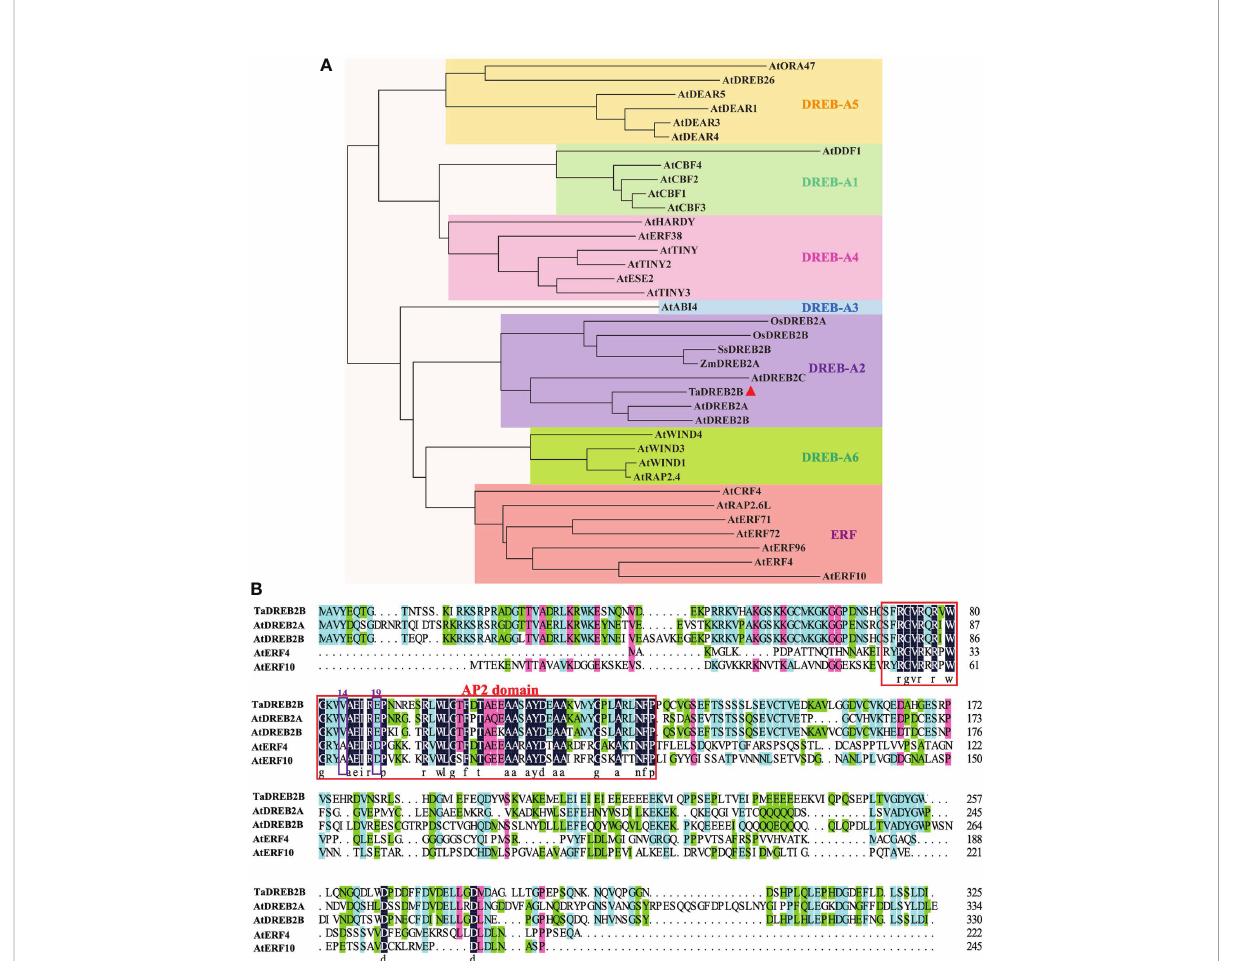
FIGURE 1 Phylogenetic tree and amino acid sequence alignment of TaDREB2B. (A) Phylogenetic analysis of TaDREB2B and other AP2/ERF transcription factors from Arabidopsis , rice, and maize. The red triangle represents the TaDREB2B protein. (B) Alignment of TaDREB2B, AtDREB2A, AtDREB2B, AtERF4 and AtERF10 protein sequences. The red rectangle represents the AP2 domain, and the purple rectangles show the amino acid on the 14th and